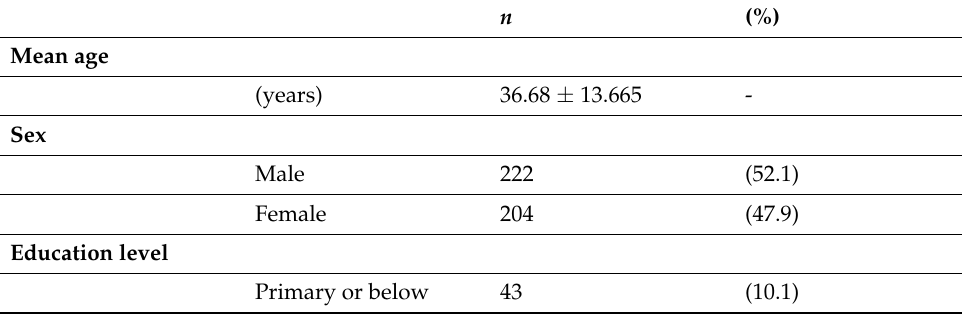
Table 1. Demographic characteristics ( n =